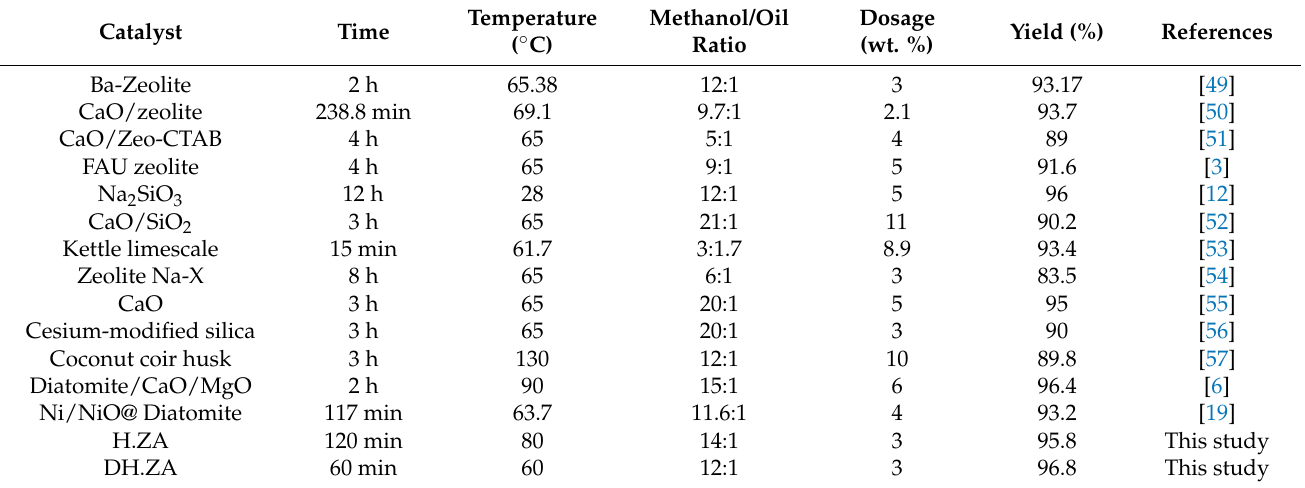
Table 6. Comparison between the obtained biodiesel yield using the H.ZA and DH.ZA catalysts and other catalysts in